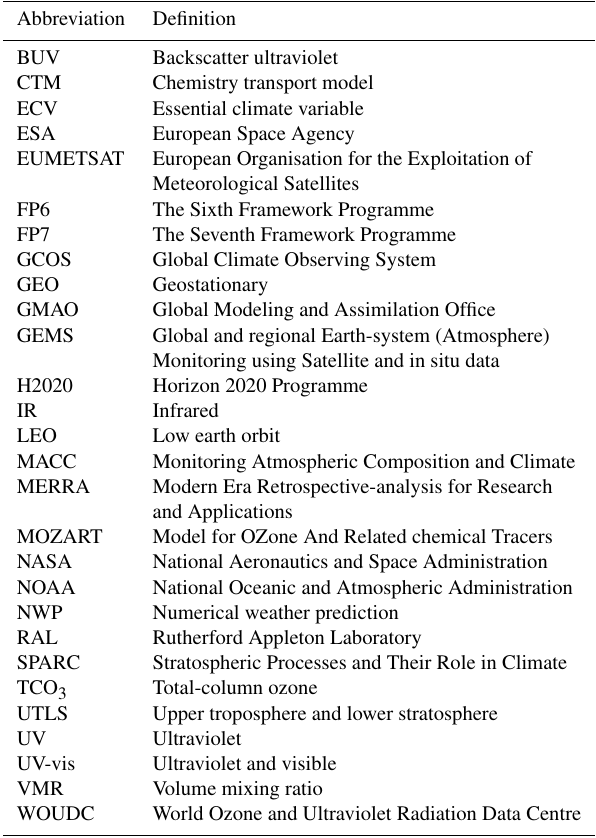
Table 1. List of abbreviations for the satellite platforms and instru- ments used in this paper.